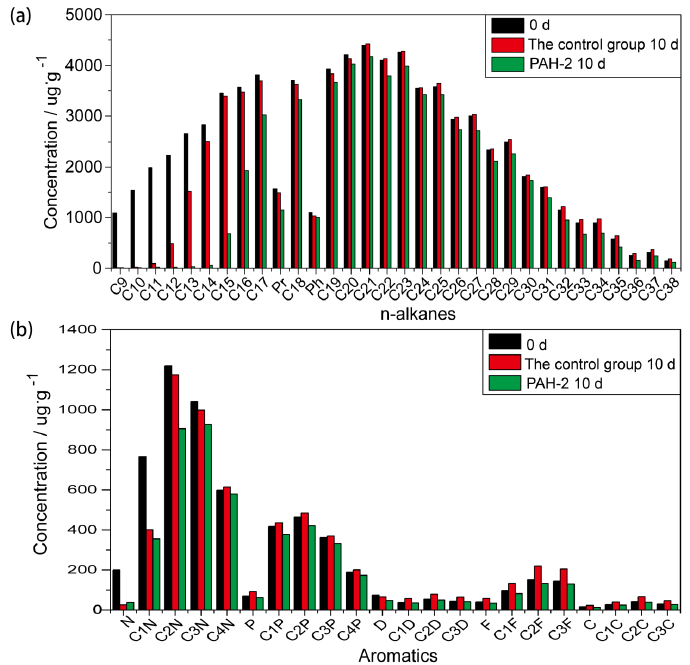
Figure 7. The percentage degradation of n-alkanes and aromatics in the crude oil by PAH-2 for 10 days. ( a ) the degradation in the chain length of hydrocarbon. ( b ) the degradation in aromatic com- ponents.